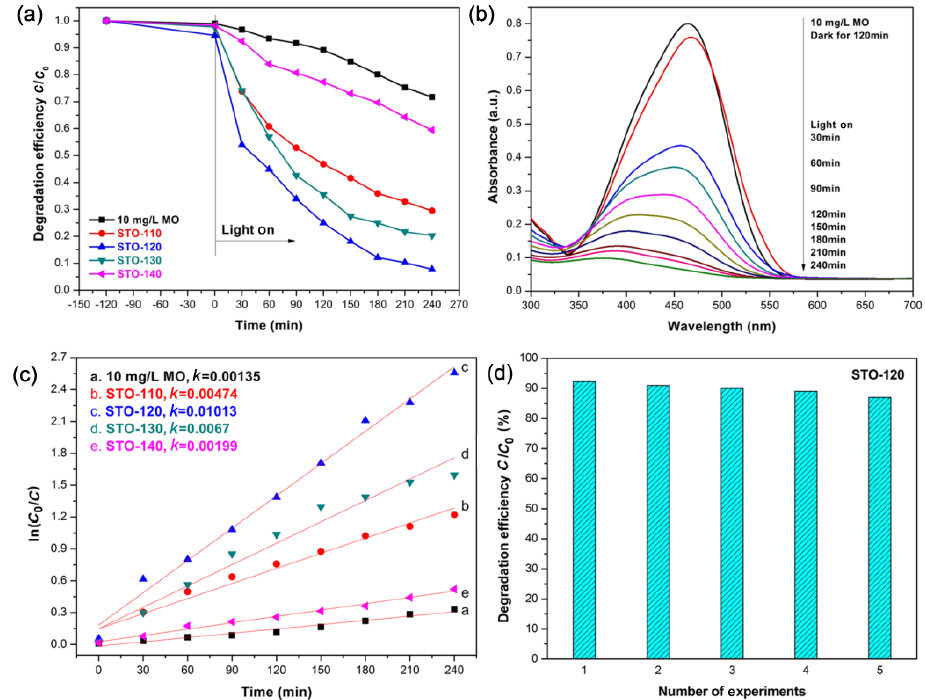
Fig. 7 (a) Photocatalytic degradation of MO as a function of time using SrTiO 3 NPs; (b) temporal changes in the UV–Vis spectra of MO aqueous solution during the photodegradation reaction under irradiation with ultraviolet light within 240 min in the presence of the sample STO-120 photocatalyst; (c) the linear fitting of photocatalytic degradation process of MO solution (3×10  5 M, 50 mL) containing 50 mg of SrTiO 3 nanoparticles; and (d) the reusability of STO-120 under 240 min